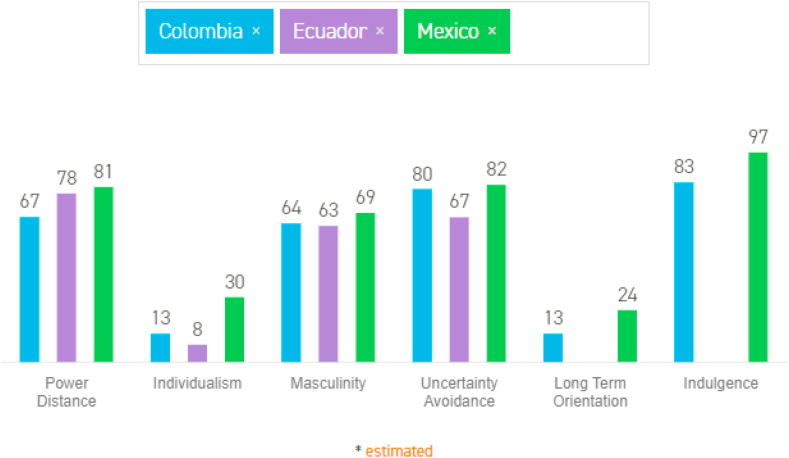
North American country (as Mexico) Vs. South American countries (as Colombia and Ecuador). Source: (Hofstede, 2020a, Hofstede, 2020b).